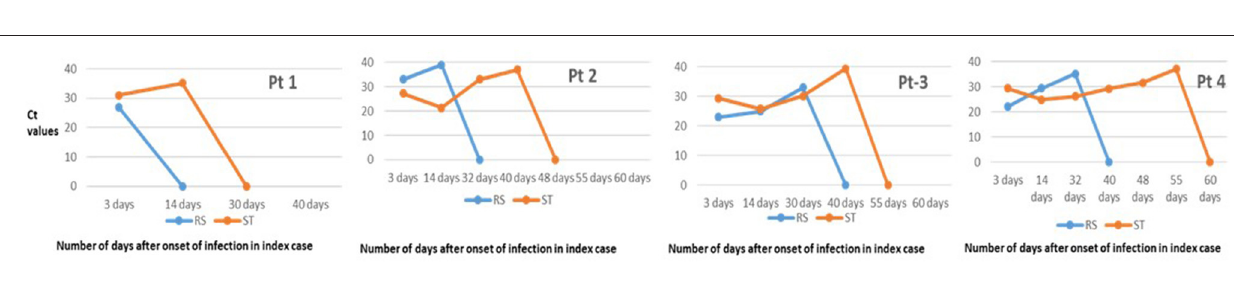
FIGURE 4 | Chronologic changes in RT-PCR testing